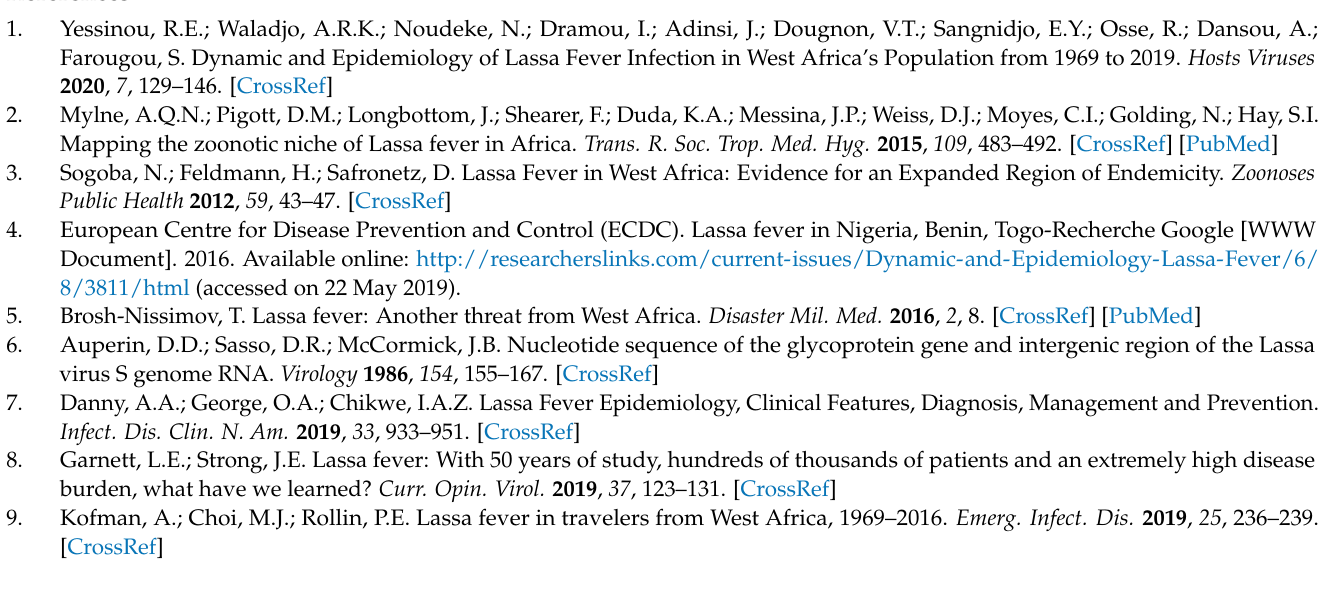
Analysis and Figure/Table Creation: C.A., O.U.O., C.O.E. (Chuks Oswald Edeogu) and